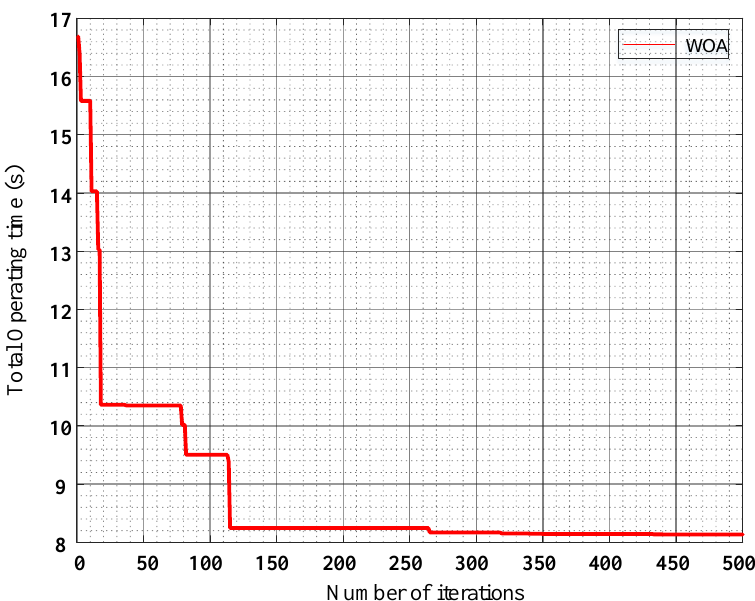
Figure 8. Convergence characteristic of WOA for Case 3.